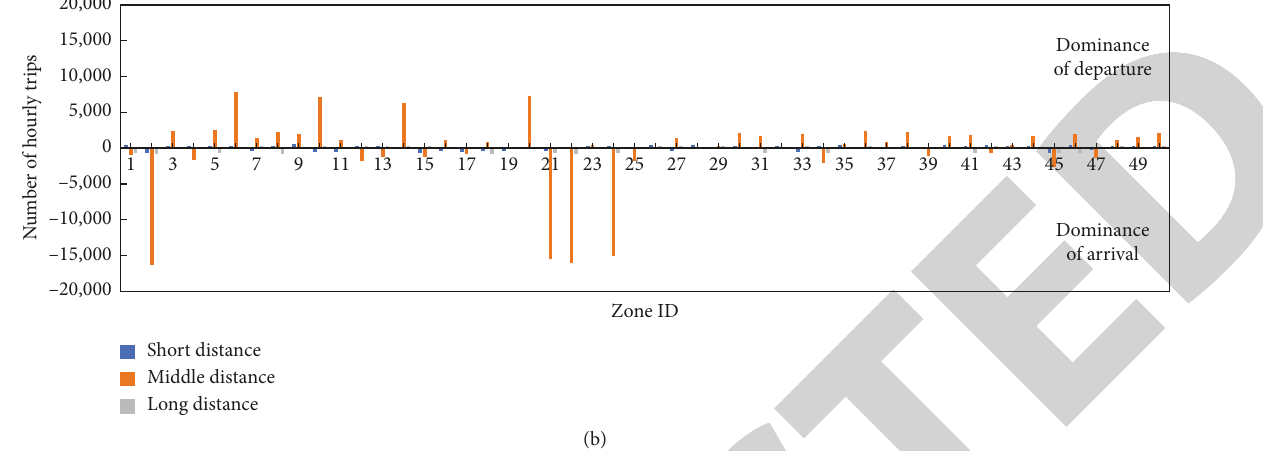
Figure 5: Validation of the results. (a) Comparison between temporal topics and user routines. (b) Comparison between spatial topics and user